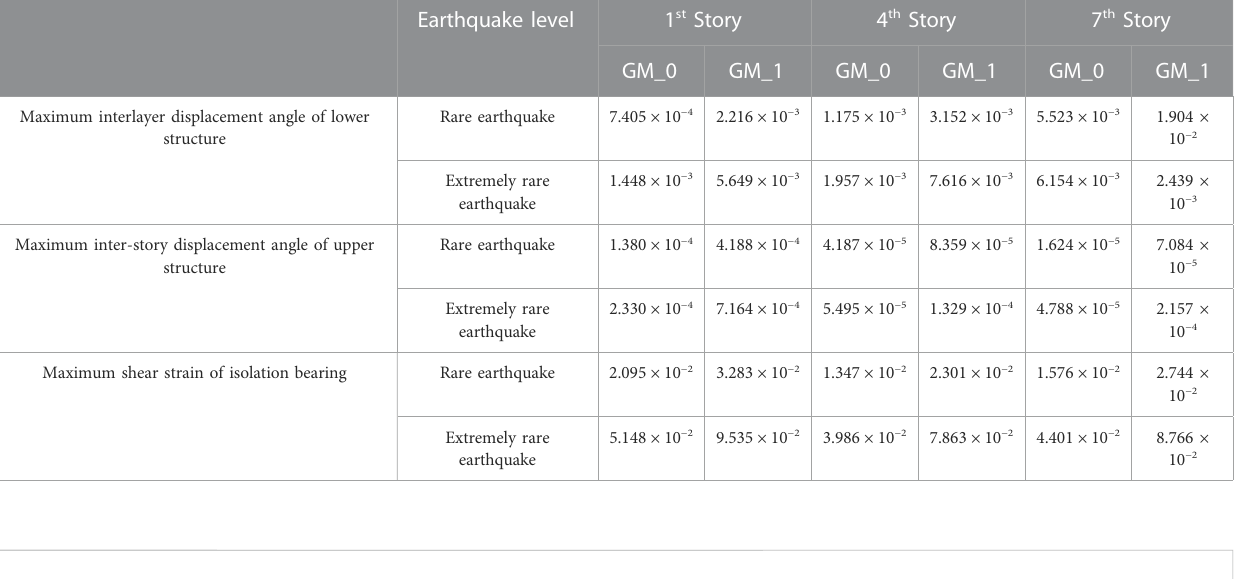
TABLE 7 Failure probability of isolation layers set at different stories.